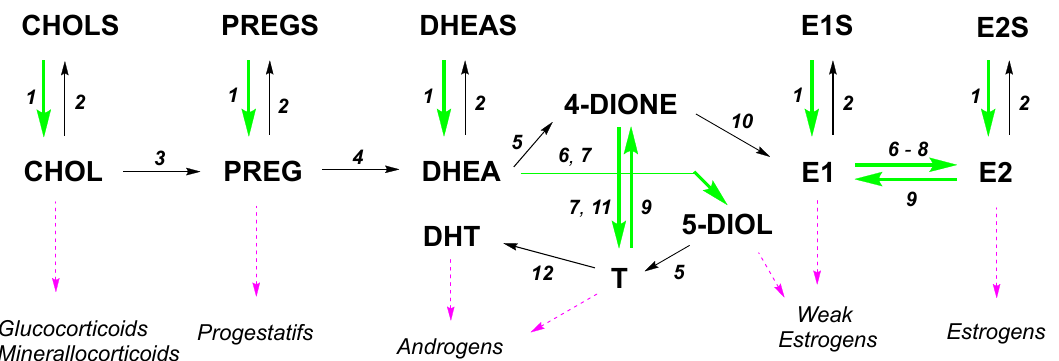
Figure 1. Crucial role of some enzymes involved in the synthesis of steroid hormones (steroidogen- esis). CHOL—Cholesterol; CHOLS—Cholesterol sulfate; DHEA—Dehydroepiandrosterone; DHEAS—Dehydroepiandrosterone sulfate; 5-DIOL—Androst-5-ene-3 β ,17 β -diol; 4-DIONE—An- drost-4-ene-3,17-dione; E1—Estrone; E1S—Estrone sulfate; E2—Estradiol; E2S—Estradiol sulfate;